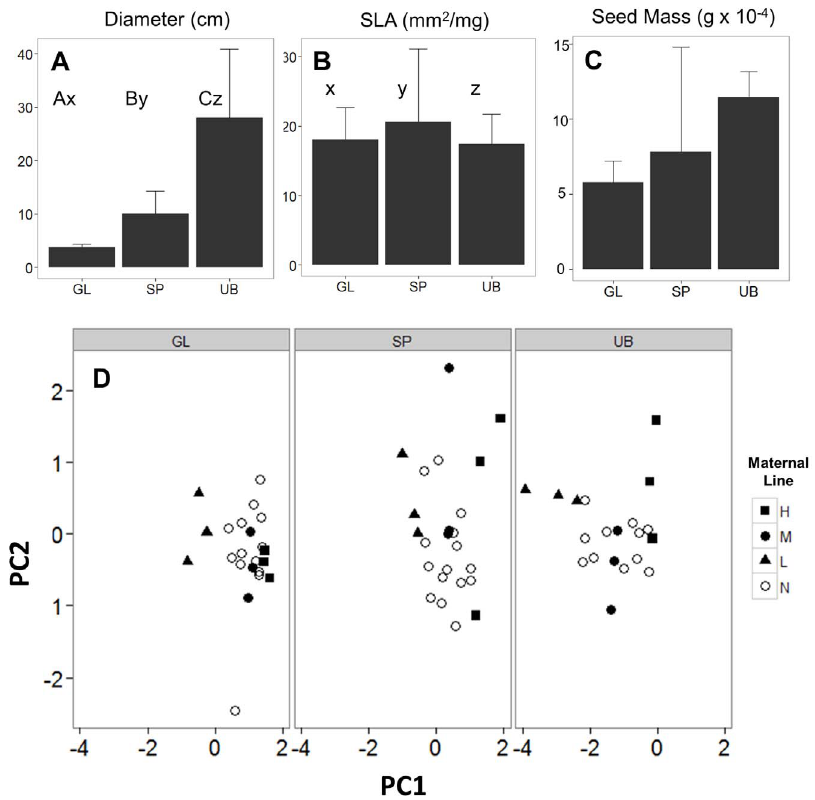
Figure 1. Mean ( + SD) of field-based measurements of three traits for the populations of origin (GL: Glacial Heritage; SP: Smith Prairie; UB: Union Bay). Significant PERMANOVA results ( a =0.05) are indicated by different uppercase letters and significant PERMDISP results are indicated by different lowercase letters. D) Results of a Principal Components Analysis of the three traits measured on individuals from each population. Populations were analyzed together, but are shown in separate graphs for clarity. PC1 explained 49% of observed variation. Filled symbols indicate maternal ‘‘high’’ (H), ‘‘medium’’ (M) and ‘‘low’’ (L) maternal lines used in the greenhouse experiment, while open symbols (N) indicate maternal lines measured in the field but not included in the